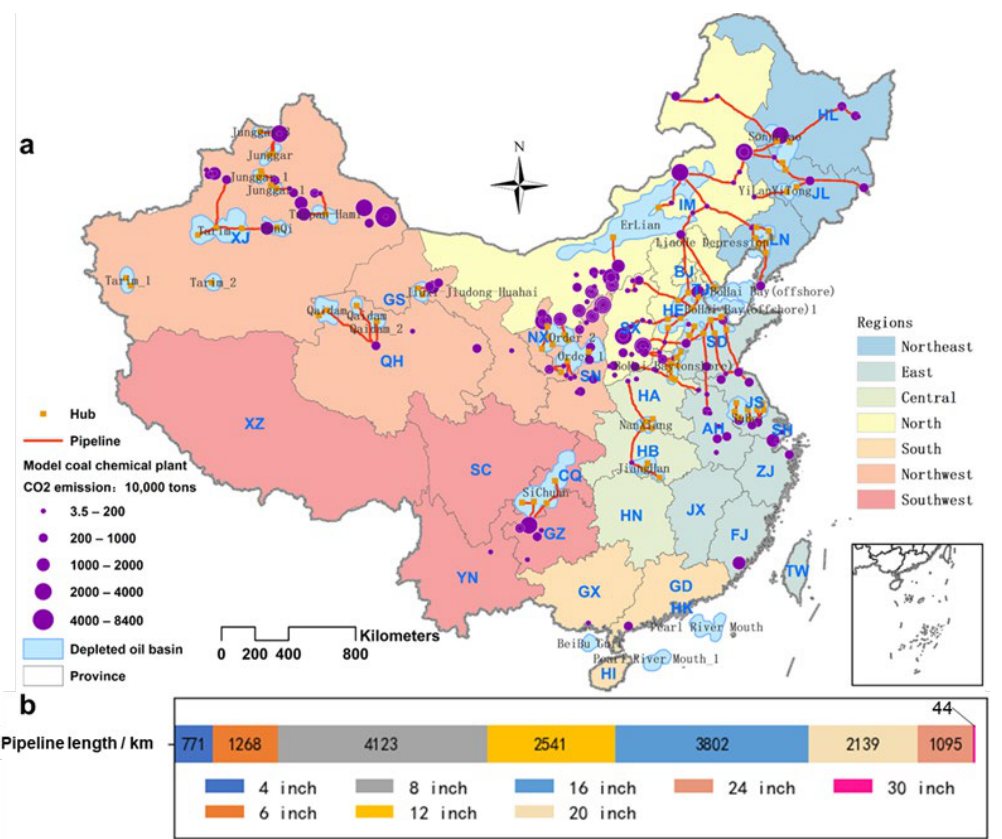
Figure 3. CO 2 -EOR pipeline network layout of modern coal chemical industry. ( a ) shows the optimized national pipe network layout, and ( b ) shows the length of pipes with different diameters.